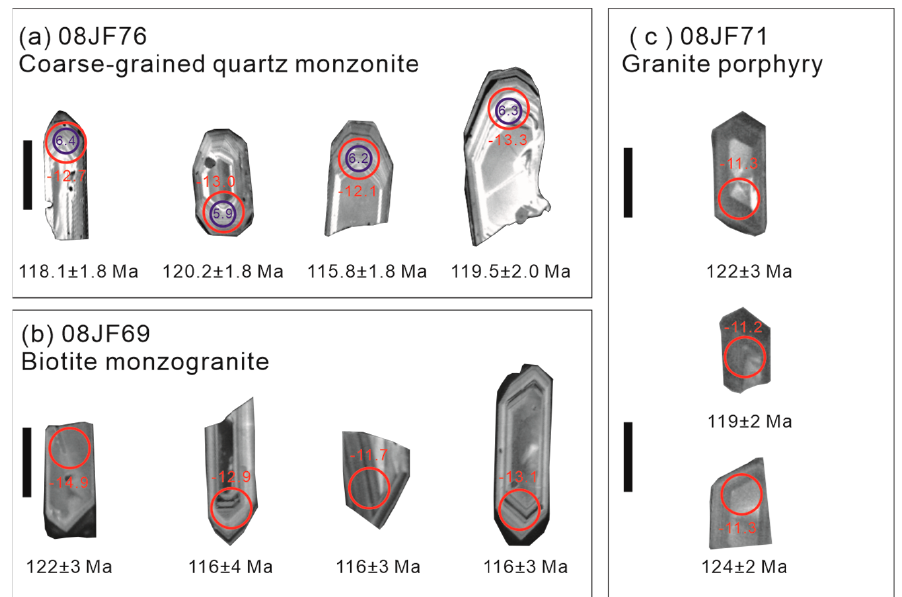
Figure 3. Representative cathodoluminescence (CL) images of zircons from the ( a ) coarse-grained quartz monzonite, ( b ) biotite monzogranite, and ( c ) granite porphyry in the Yushulinzi pluton. The blue circles represent the sites of the O isotopic analysis and the subsequent U-Pb dating analysis via SIMS. The red circles represent the locations of the U-Pb age analyses and the subsequent Hf isotope measurements via LA-(MC)-ICPMS. The scale bars in all of the CL images are 100 µm in length. The U-Pb age and δ 18 O and ε Hf (t) values of the zircons are noted for each analytical grain.